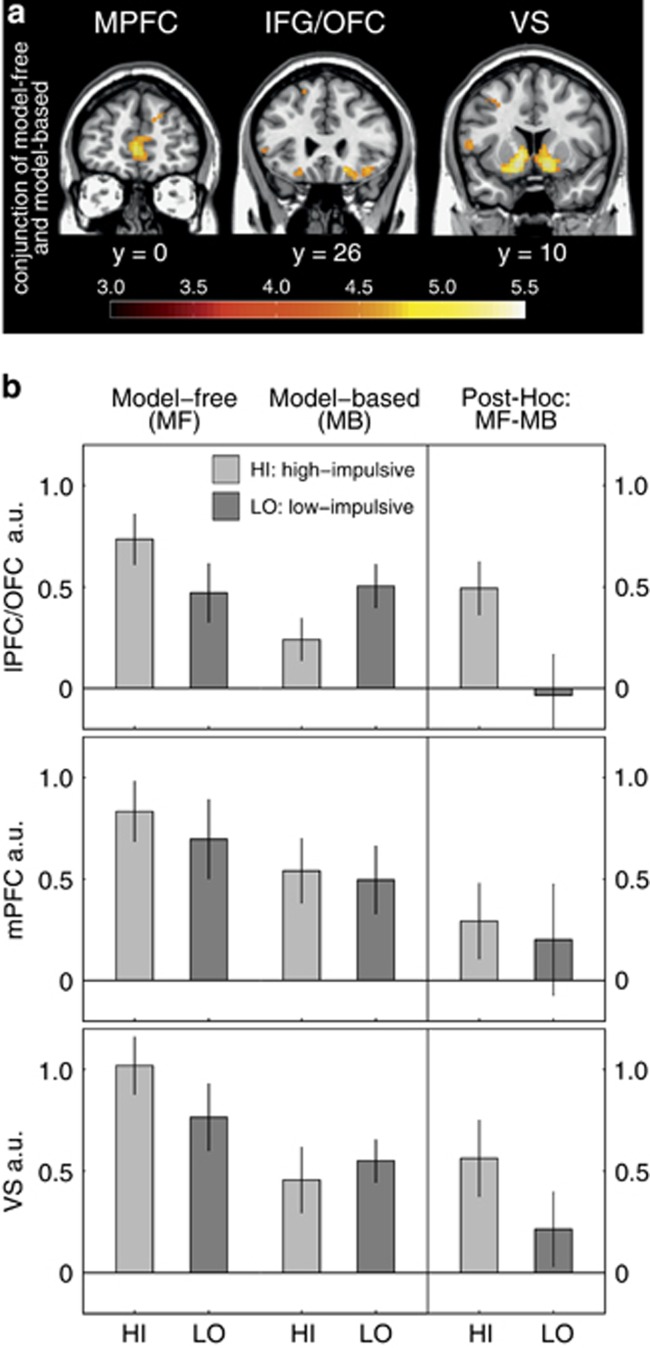
Functional magnetic resonance imaging (fMRI) results across the entire sample. (a) Across both groups a significant (whole-brain p-family-wise error (FWE)<0.05 at the cluster level) conjunction of model-free reward prediction errors and the difference of model-based and model-free prediction errors was observed in the right and left ventral striatum (VS), medial prefrontal cortex (mPFC), right ventrolateral prefrontal/orbitofrontal cortex (OFC), right and left parietal cortex and posterior cingulate cortex. For display purposes, maps are thresholded at P<0.001 uncorrected and a cluster extent of k=20. (b) The mean parameter estimates of the cluster for bilateral ventral striatum, medial and right ventrolateral PFC tested between groups using three repeated-measures analysis. No main effect of impulsivity (F(1,46)⩽0.28, P⩾0.60) nor an impulsivity × control interaction was observed (F(1,46)⩽1.79, P⩾0.19) in the ventral striatum and medial PFC (b, middle and lower panel). In right lateral PFC (b, upper panel), we observed no main effect of impulsivity (F(1,46)<0.01, P=0.99) but a significant impulsivity × learning interaction (F(1,46)=4.80, P=0.03). IFG, inferior frontal gyrus; lPFC, lateral prefrontal cortex; n.s., non-significant.